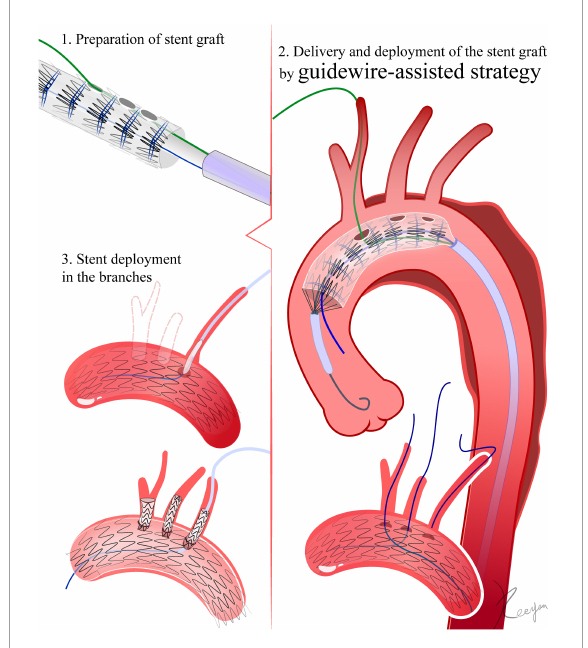
FIGURE4 Guidewire-assisted strategy. 1. The fenestration is made in vitro according to the peri-operative CTA. After fenestration, a 0.018-inch guidewire passes through needle holes in the distal part of the delivery sheath into the fenestration. Diameter-reducing ties are added to the devices. 2. The 0.018-inch guidewire passes through the fenestration into the branch artery. Several segments of the stent graft are released. With the help of diameter-reducing ties, the stent graft is not fully deployed. Then, the fenestration site is aligned to the greater curve of the aortic arch by rotating the delivery system. After verifying that the fenestration is oriented toward the branch artery, the stent graft is fully released. 3. Deployment of stents in the